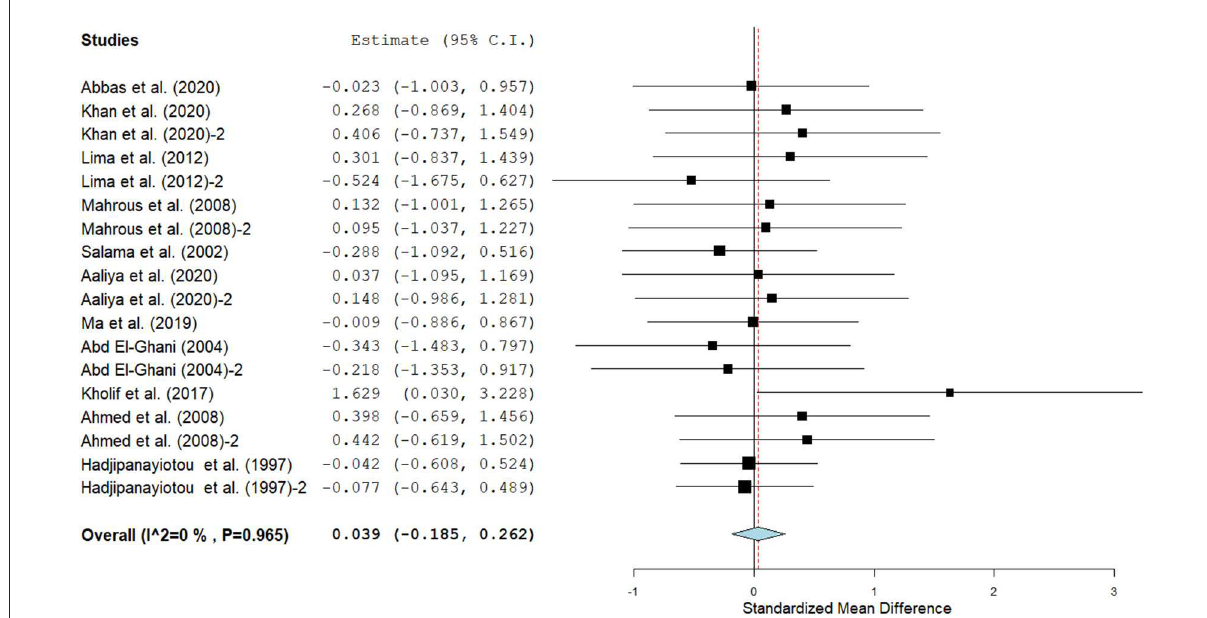
FIGURE8 The forest plot of the effect of SC on milk total solids in lactating goats. The error bars connote the SMD of each trial, while the upper and lower 95% CIs for the effect size are the line that joined the individual square box. The thick vertical line is the line of no effect (SMD = 0), which suggests no effect of SC supplementation on milk total solids. The sky-blue diamond at the base of the plot indicates the pooled SMD with its width representing the 95% confidence intervals for the effect size. The points to the right of the line of no effect suggest an increase in milk total solids. The points to the left of the line of no effect connote an increase in milk total solids. I 2 is the inconsistency